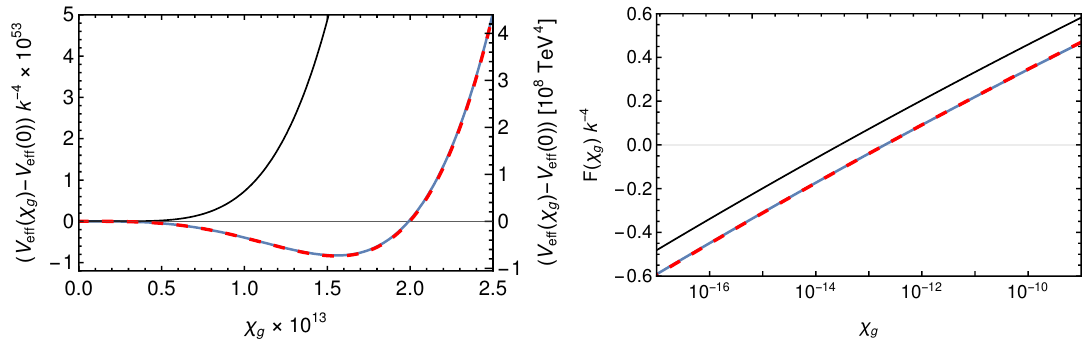
Figure 6 . Exact and approximate e(cid:11)ective potential for a system with (cid:20) = 0 : 5 k (cid:0) 3 = 2 , (cid:15) = 0 : 01, v 1 = 0 : 1 k 3 = 2 , v 2 = 4 : 5 k 3 = 2 and (cid:3) 2 = (cid:0) 150 k 4 . Then, k = 1 : 72 (cid:2) 10 15 TeV (2.27). The black line is V e(cid:11) ( (cid:31) g ) (cid:0) V e(cid:11) (0) calculated with the approximation (4.13). The blue line gives the exact potential V e(cid:11) ( (cid:31) g ) (cid:0) V e(cid:11) (0) calculated numerically. The dashed red line (indistinguishable from the blue one) is the hybrid approximation: (4.13) with the substitution (4.18) after computing numerically (cid:31) y; min . On the left we plot the e(cid:11)ective potential using linear scales for the axes. The left vertical axis is given in units of k 4 and the right one, in TeV 4 . On the right, we plot F ( (cid:31) g ) = ( V e(cid:11) ( (cid:31) g ) (cid:0) V e(cid:11) (0)) =(cid:31) 4 using a logarithmic scale for the horizontal